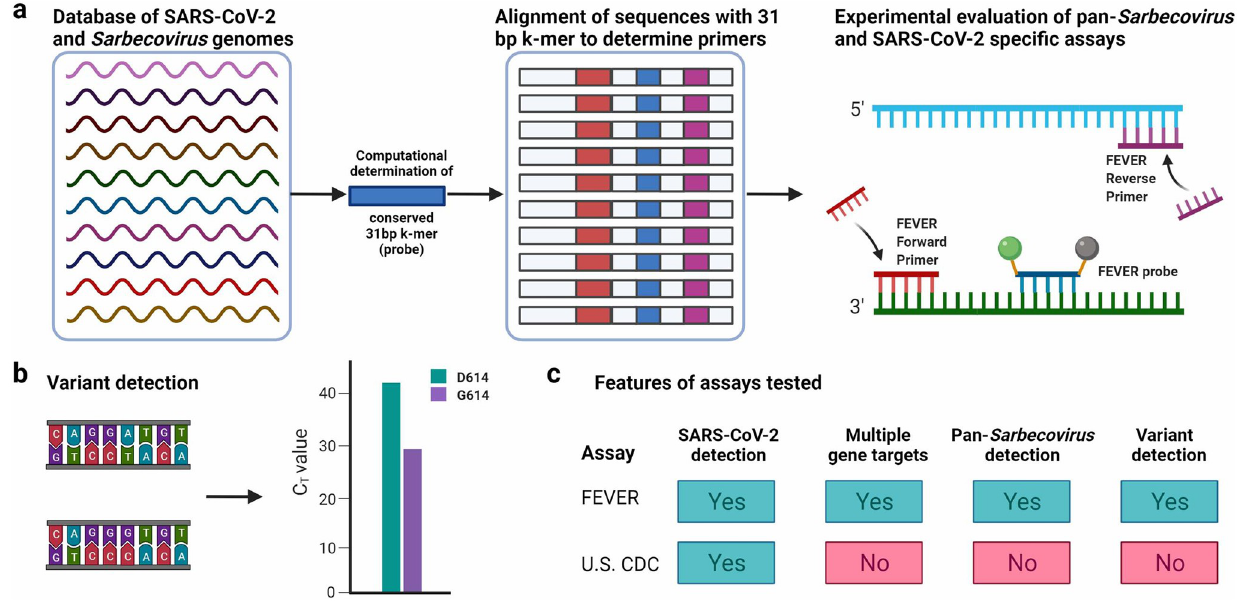
Fig 1. Schematic of FEVER assay approach and comparison of features to the U.S. CDC SARS-CoV-2 assay. ( a ) Overview of compiling a database of SARS-CoV-2 and Sarbecovirus genome sequences to generate FEVER primer and probe sets. ( b ) Assays were designed to detect the D614G variant. ( c ) The tabulated features of the FEVER assays compared with the U.S. CDC SARS-CoV-2 assay.